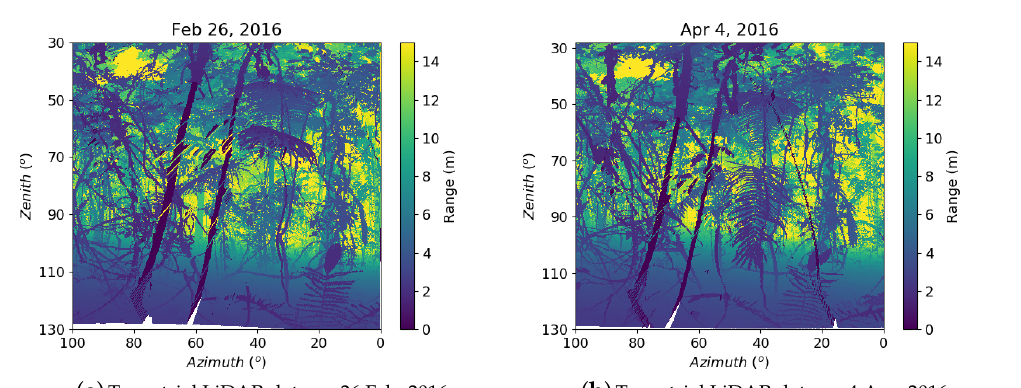
Figure 4. View of terrestrial LiDAR data from one scan position of the control plot with azimuth ranging from 0 ◦ to 100 ◦ and zenith ranging from 30 ◦ to 130 ◦ . The data is colored according to the range of the laser